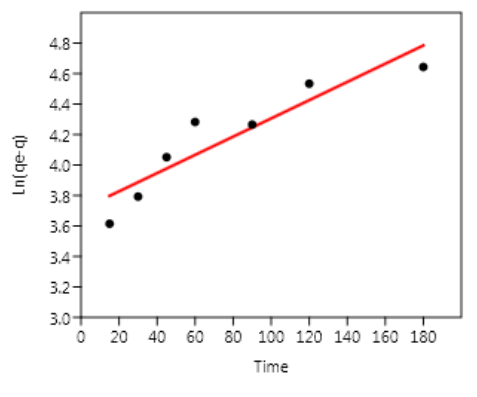
Figure 11. The Pseudo-second-order kinetics of the adsorp- tion of nitrite by chitosan-activated carbon nanocomposite